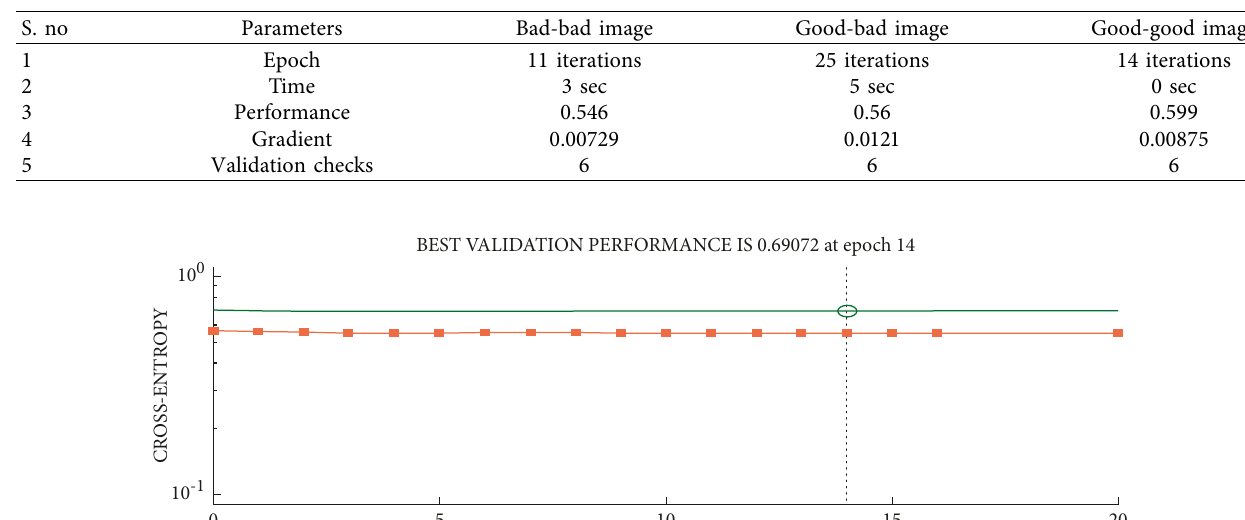
Table 3: Iteration